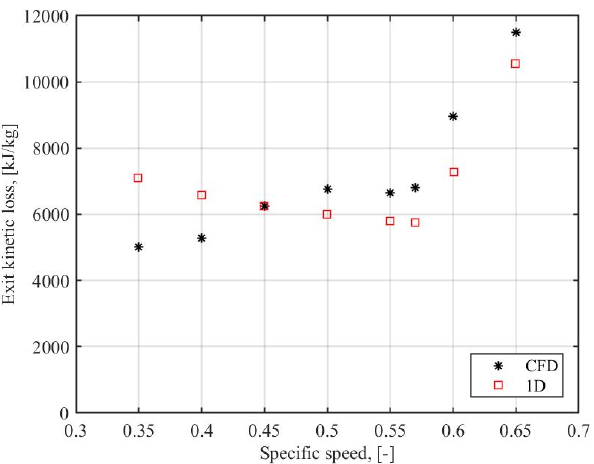
Figure 6. Turbine rotor exit kinetic loss predicted by using CFD and 1D design.